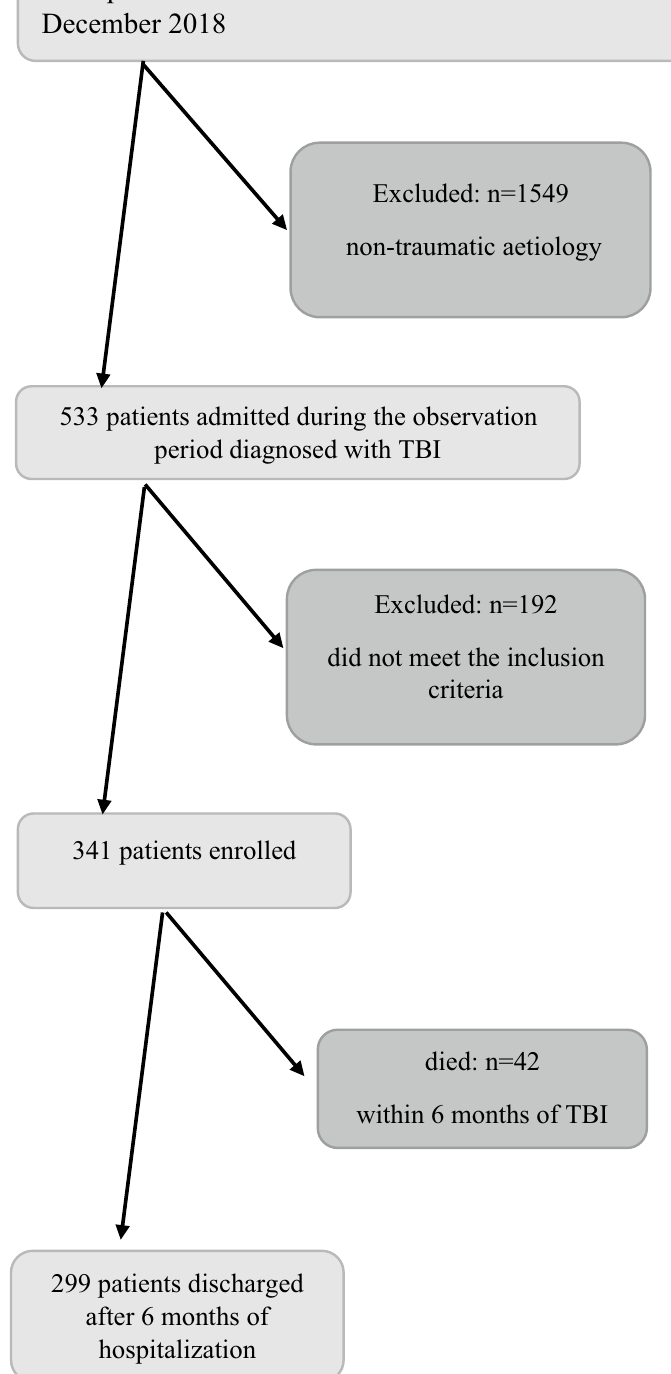
Figure 1. Consolidated standards of reporting trials (CONSORT)-like flow chart representing patient inclusion up to 6 months after traumatic brain injury